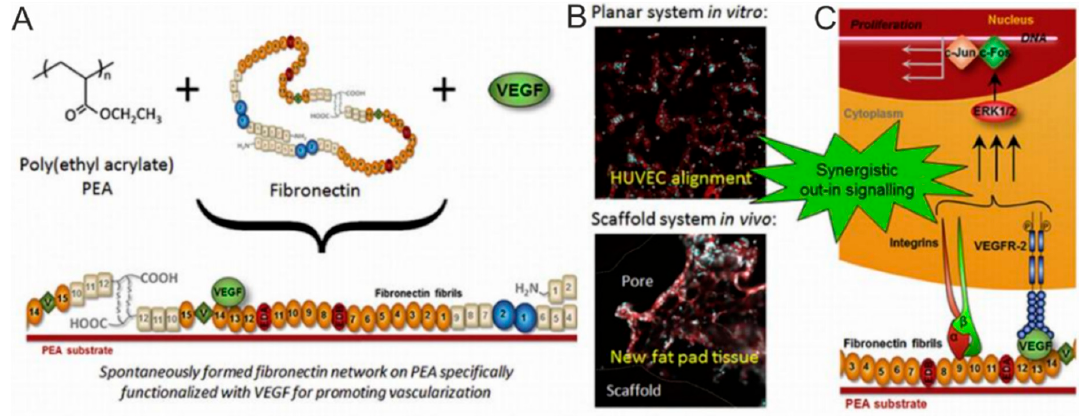
Figure 3. ( A ) Synergistic triggering of the integrin-VEGF signal, which is connected to the Poly (ethylene adipate) network. ( B ) In vitro and in vivo fluorescence microphotographs of cells. ( C ) Scheme of the effect of VEGF associated with nanofibrils on cell signaling. Reprinted with permission from Elsevier, 2017